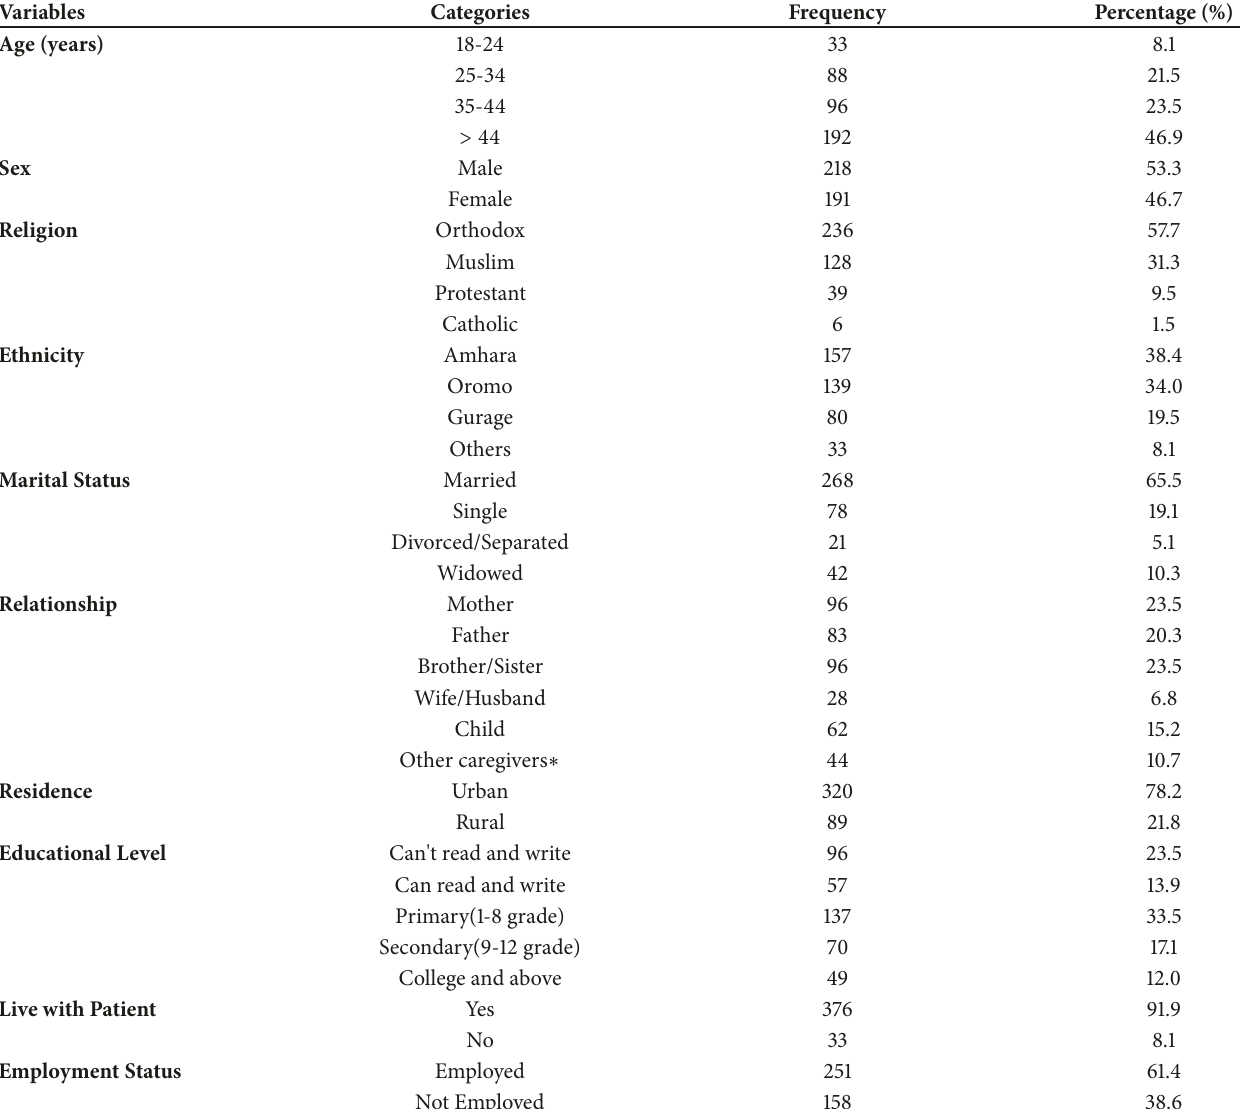
Table 1: Socio-demographic characteristics of caregivers of patients with epilepsy at Amanuel Mental Specialized Hospital, Addis Ababa, Ethiopia, 2017